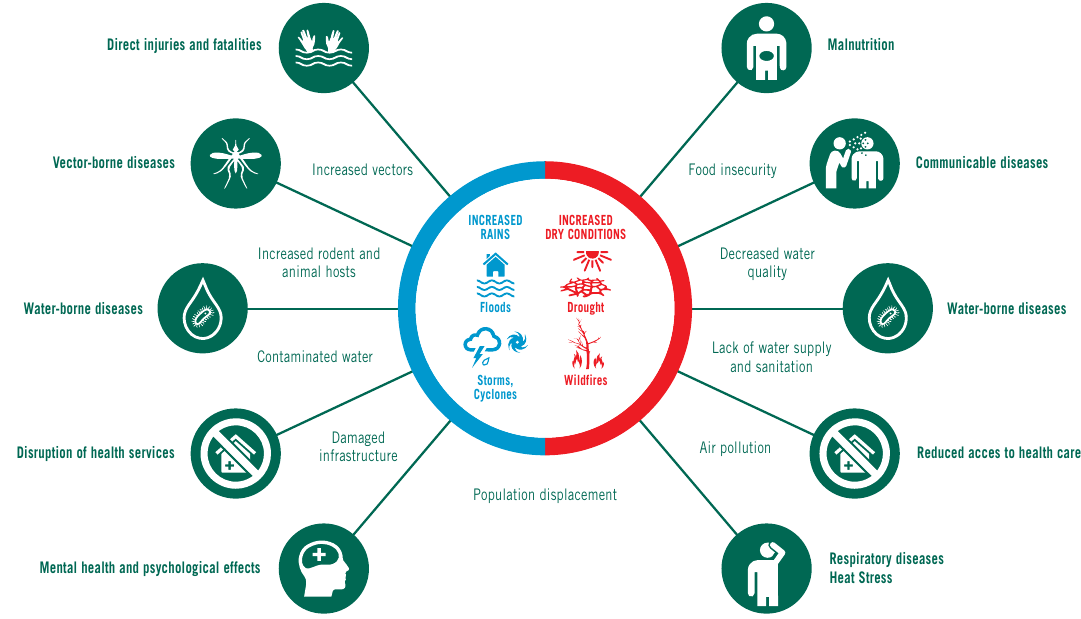
Figure 10. Range of El Niño related health impacts. Sourced and redrawn from the World Health Organisation. http://www.who.int/hac/crises/elnino/who_el_nino_and_health_global_report_